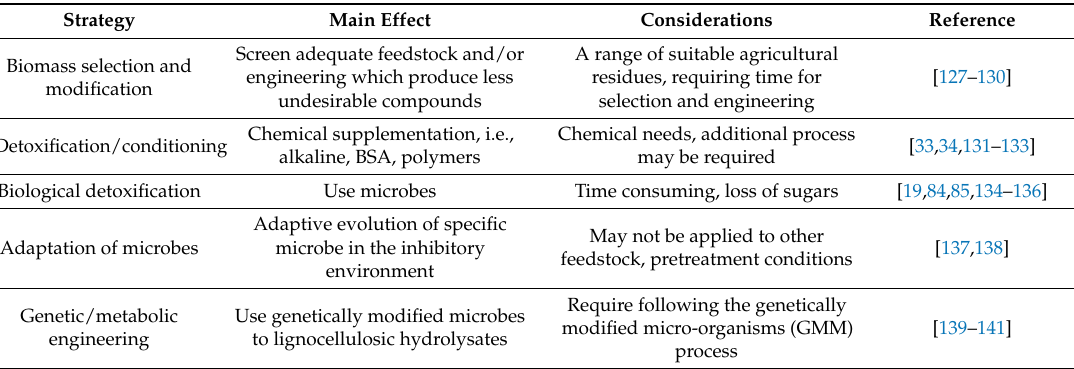
Table 4. Summary of strategies to counteract lignocellulose-derived inhibitors released during pretreatment